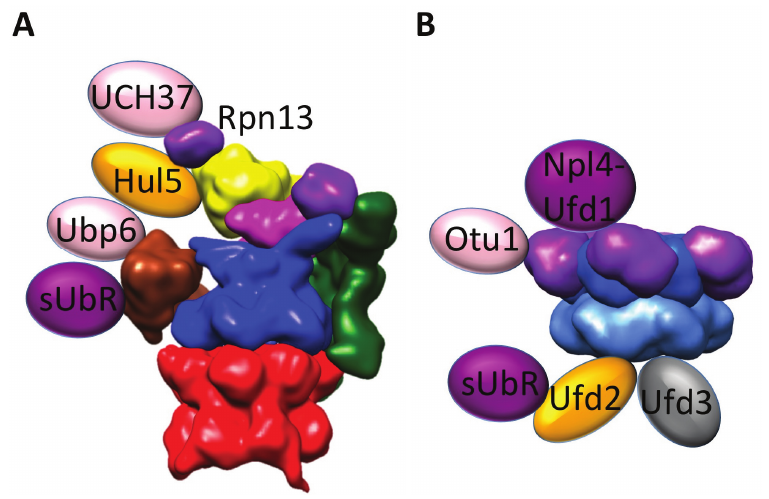
ubiquitin-proteasome system (UPS). ( A ) Proteasome-interacting proteins (PIPs). The DUB Ubp6 and all shuttling Ub receptors (sUbR), Rad23, Dsk2 and Ddi1, bind to Rpn1 via